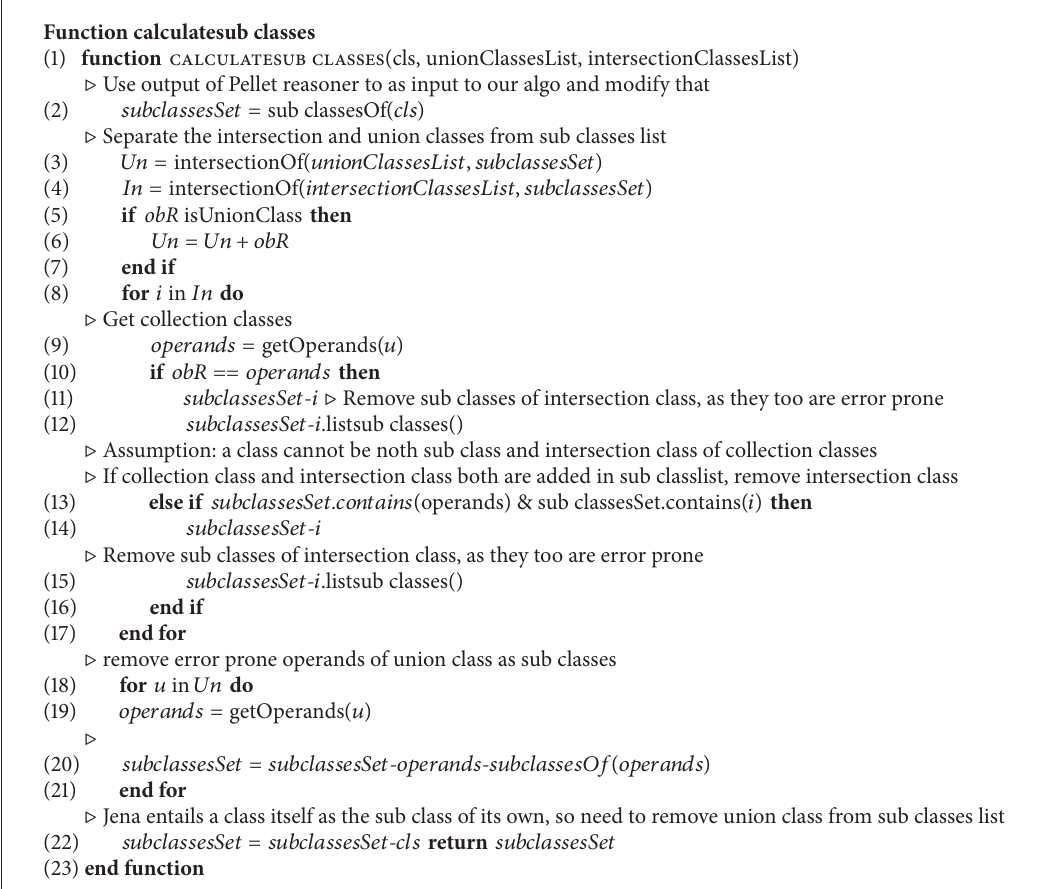
Algorithm 2: Pseudo code of our Calculated subclasses